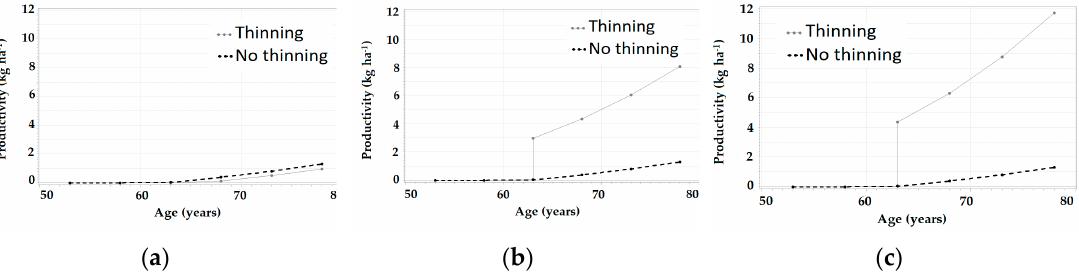
Figure 2. Total mushroom productivity with no thinning and with thinning activities corresponding to G10 ( a ), G25 ( b ), G35 ( c ) silvicultural scenarios.